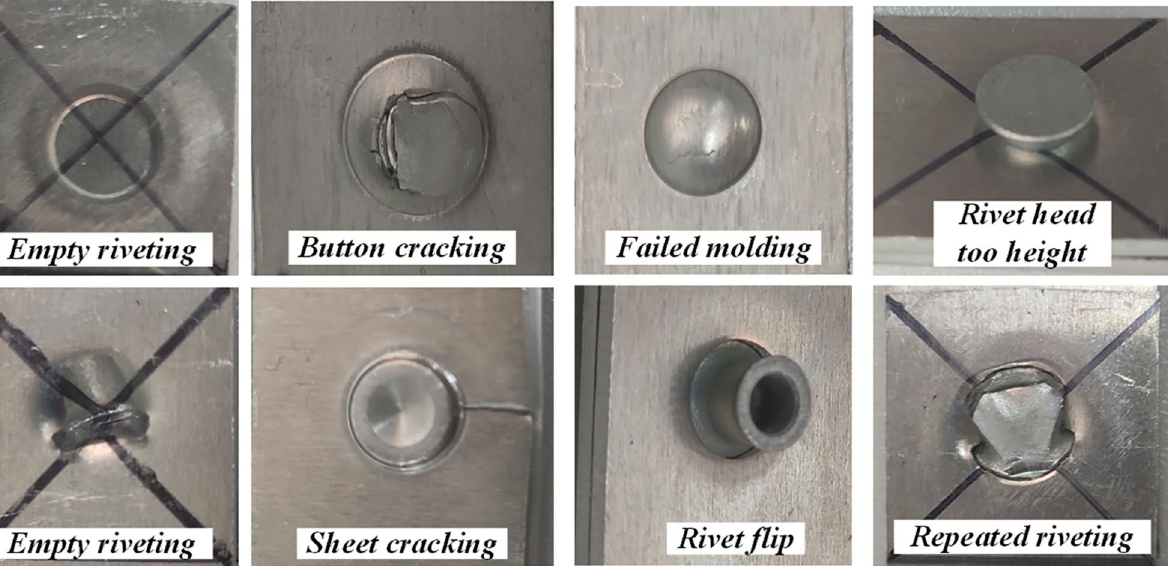
Figure 3. Types of SPR